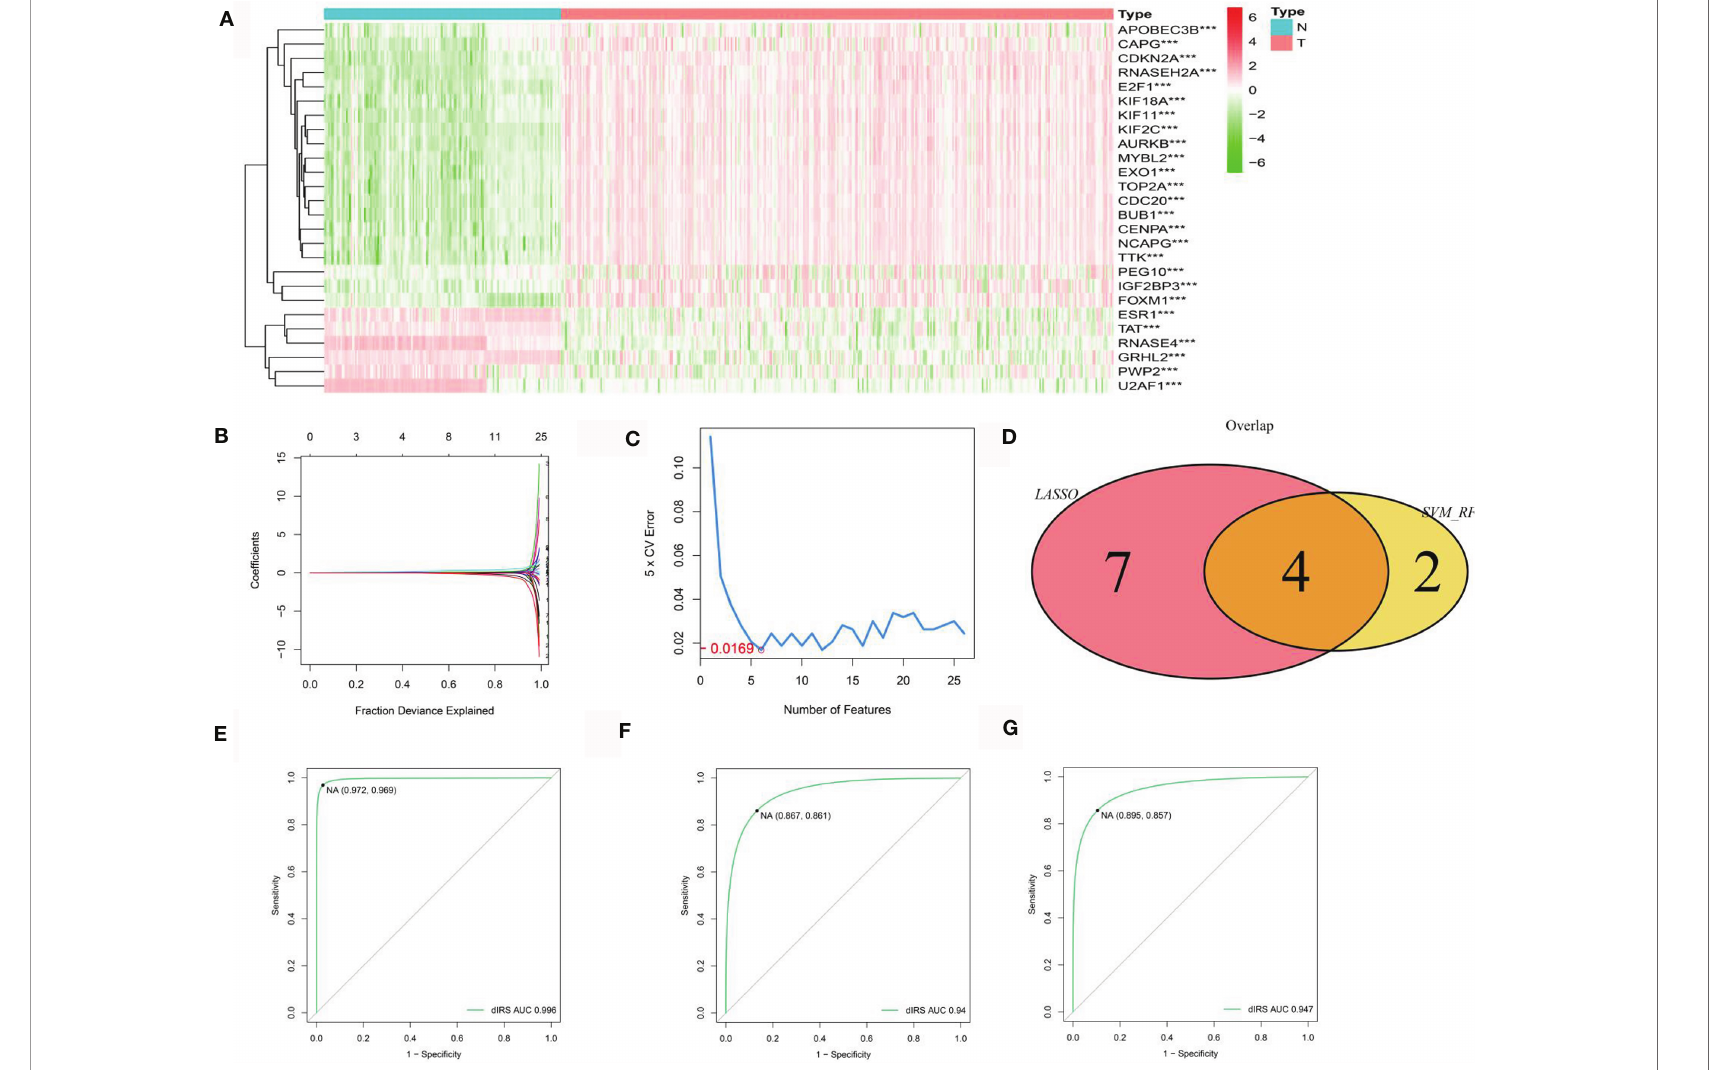
FIGURE 3 | Establishment and validation of the diagnostic signal for HCC. (A) Twelve ERGs with signi fi cantly different expression based on the GTEX-TCGA data set. (B) Lasso regression analysis of the above ERGs. (C) Support vector machine analysis of the above ERGs. (D) The characteristic value is based on the intersection of SVM and lasso analysis. (E) The ROC curve of the diagnostic signal showing the sensitivity and speci fi city based on the GTEX-TCGA data set. (F) The ROC curve of the diagnostic signal showing the sensitivity and speci fi city based on the ICGC-LIHC data set. (G) The ROC curve of the diagnostic signal showing the sensitivity and speci fi city based on the GSE14520 data set.